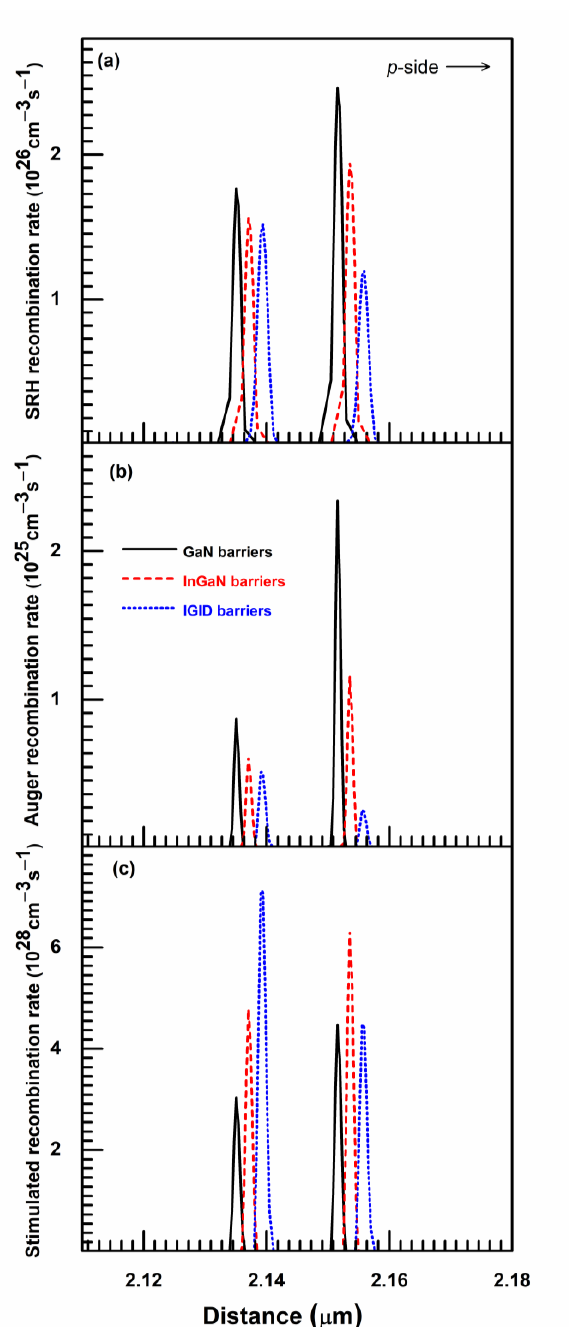
Figure 6. The SRH, Auger, and stimulated recombination rates for the ( a ) GaN, ( b ) InGaN, and ( c ) IGID LDs.